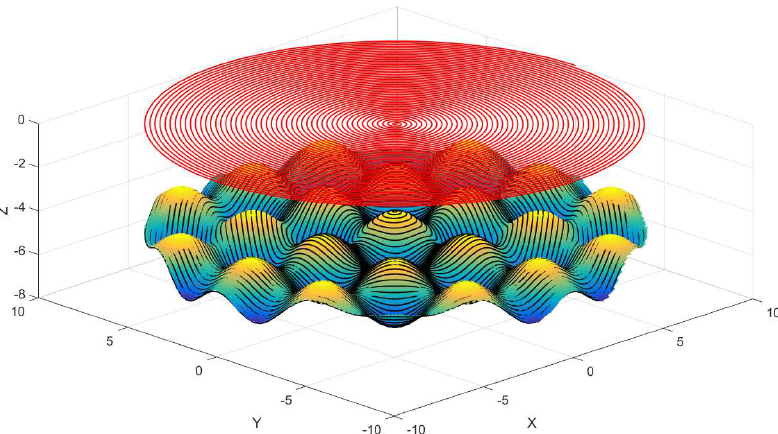
Figure 9. Illustration of tool contact points generation.